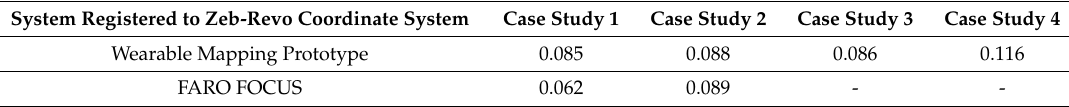
Table 10. Error in point cloud registration (RMSE). Units: